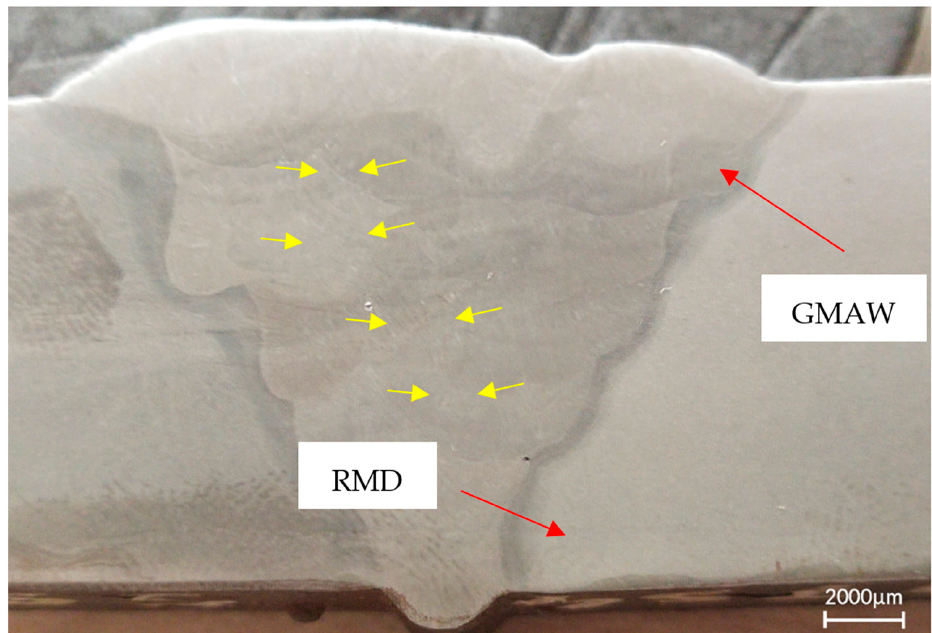
Figure 6. Macrostructure analysis of welded joint.